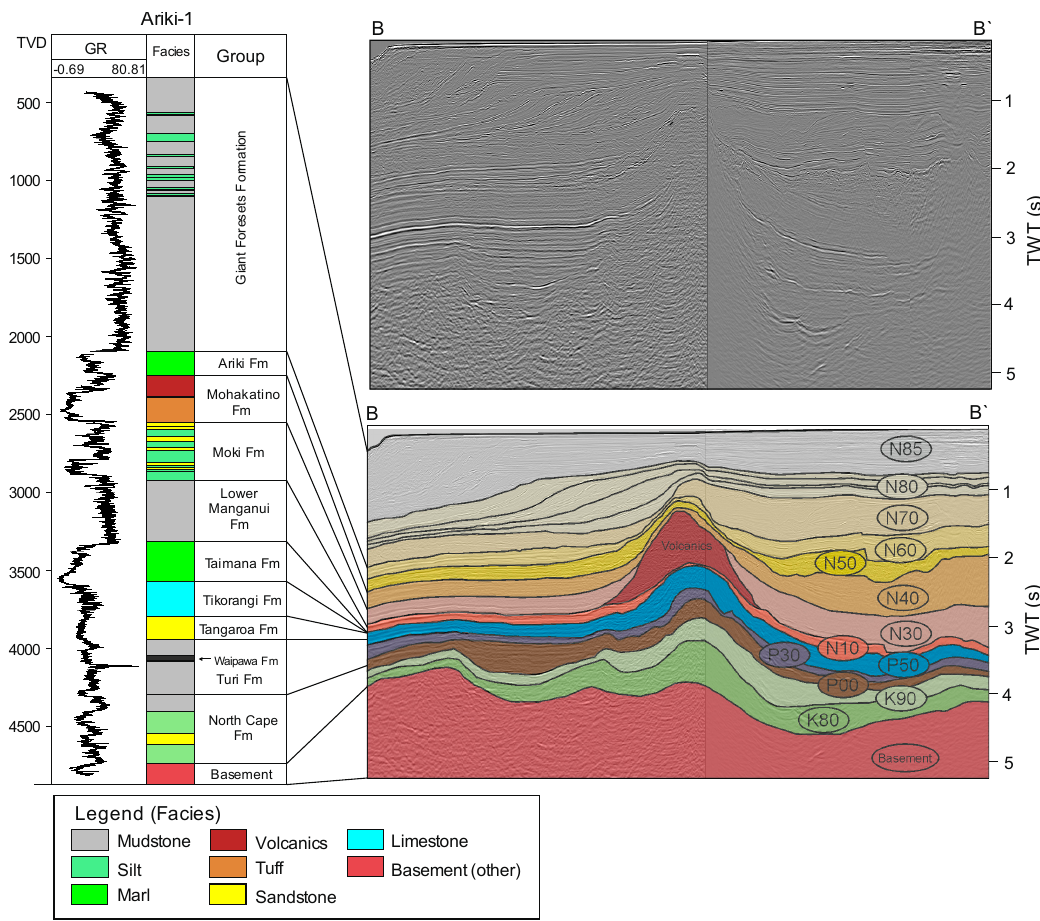
Figure 3. Composite seismic line and interpretation of submarine Kora volcano (see Figure 1 for location). Gamma ray log with interpreted facies. Syn-volcanic sediments (N60–N10) have a wedge shape, whereas pre-volcanic sediments (P50–K80) are rather uniform in their thickness. GR = gamma ray log; TVD = true vertical depth. For location, see Figure 1. The ages of interpreted horizons ae indicated in Figure 2. The colors of the interpreted horizons on section B–B’ correspond to Zealandia-wide horizon name scheme.